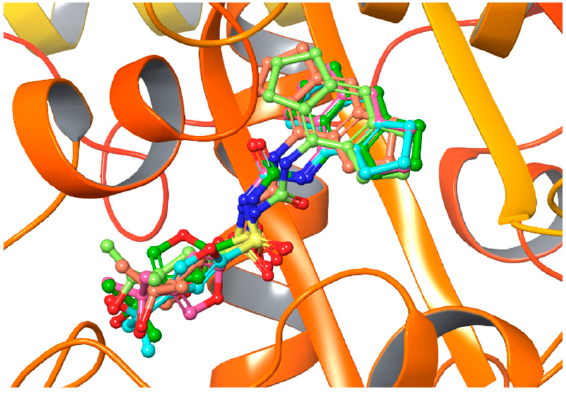
Figure 3. The five best poses of MCC950 from the XP docking experiment on the centered Walker B region.